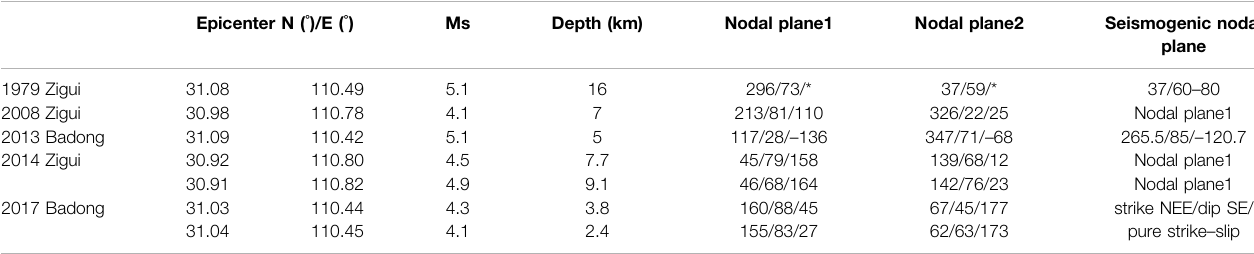
TABLE 2 | Focal mechanism solution of fi ve earthquakes. Epicenter N ( ° )/E ( °